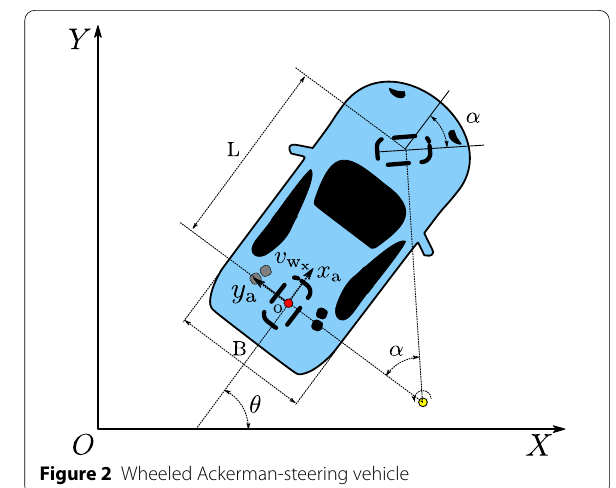
Figure 2 Wheeled Ackerman-steering vehicle